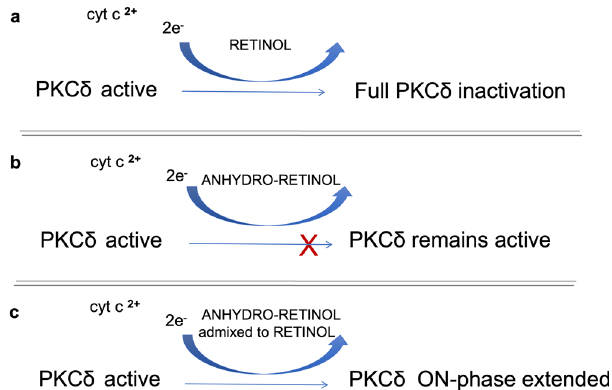
Fig. 3 Structural differences in the conjugated double bond systems of retinoids exert dramatically different effects on PKC δ . Retinol serves as electronic conduit that facilitates the bidirectional electron transfer between PKC δ and cyt c. By contrast retinoids with extended polyene systems, such as anhydroretinol, allow electron transfer in the forward, but not reverse direction, leading to redox stress. Shown are responses to different retinoids in the PKC δ inactivation pathway. a In its activated (oxidized) state PKC δ can receive electrons from cyt c 2 + , initiating the re-construction of the zinc-coordination center leading to full enzyme inactivation. b Due to its extended polyene system, anhydro-retinol (along with fenretinide) is purported to absorb a lesser quantum of energy than retinol, consequently failing to shut down PKC δ in a timely manner and leading to mitochondrial oxidative stress. c When admixed in small quantities to retinol, anhydro-retinol can transiently boost PKC δ signaling, resulting in increased fuel fl ux in